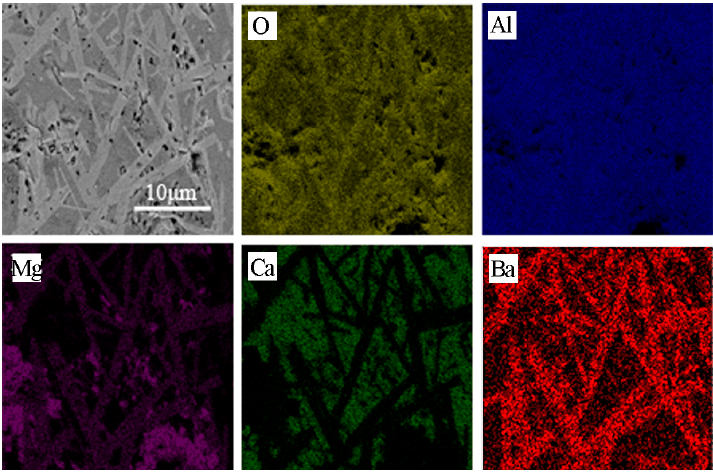
Figure 4. EDX analysis of the sample with 6 wt. % BaO addition after heating at 1600 °C in air.